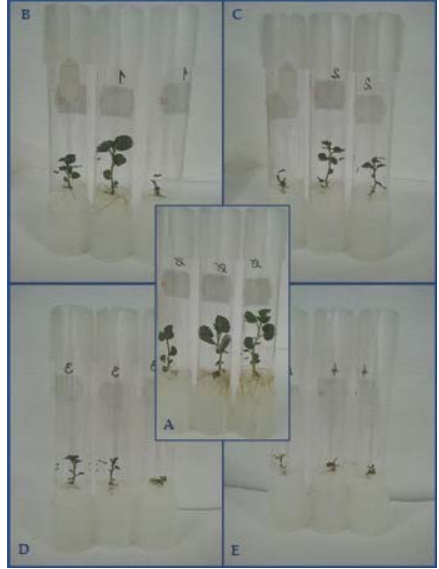
Figure 2. Effect of combined application of RBV and ZDV on V4 potato ( S. tuberosum L.) in vitro shoot culture. Control plantlets on medium without antiviral drug ( A ); plantlets grown on medium with 10 mg/L RBV + 40 mg/L ZDV ( B ); plantlets grown on medium with 20 mg/L RBV + 30 mg/L ZDV ( C ); plantlets grown on medium with 30 mg/L RBV + 200 mg/L ZDV ( D ); plantlets grown on medium with 40 mg/L RBV + 10 mg/L ZDV ( E ). Photographs were taken by authors in Nyíregyháza (Hungary).